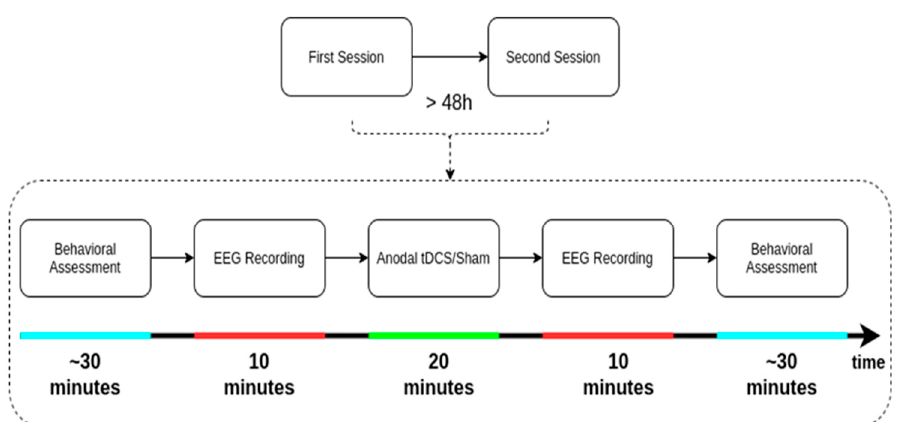
Figure 2. Protocol of the study. CRS-R = Coma Recovery Scale—Revised; EEG = electroencephalography; tDCS = transcranial direct current stimulation.